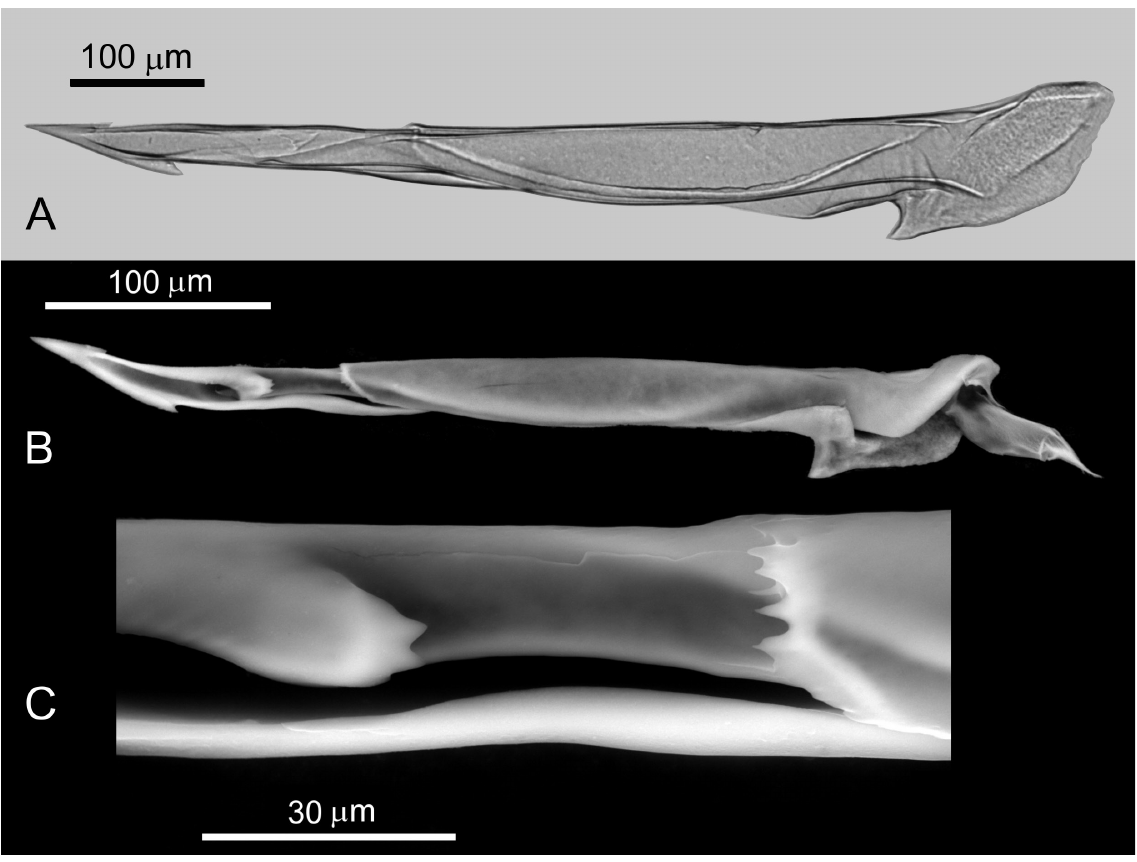
Fig. 16. Radular teeth extracted from Profundiconus neocaledonicus sp. nov. A . Optical photomicrograph (paratype 1, MNHN IM-2009-31323, S 61.3 mm). B . SEM photomicrograph (paratype 7, MNHN IM- L 2000-30785, S 54.5 mm). C . Enlargement of the middle section of L